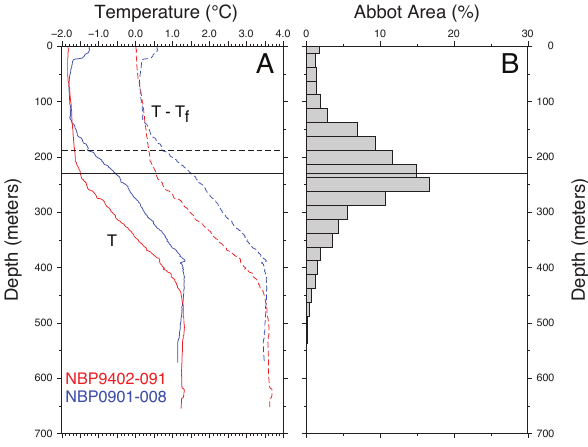
Fig. 6. (a) Measured temperature ( T ) and calculated temperature above the in situ freezing point ( T − T f ) on 13 March 1994 (CTD 091) and 14 January 2009 (CTD 008) (Giulivi and Jacobs, 1997; Ja- cobs et al., 2011) at the locations shown in Fig. 4. (b) Depth distri- bution of Abbot Ice Shelf drafts calculated from the 1km Bedmap2 compilation of surface elevation and ice thickness (Fretwell et al., 2013). Solid horizontal lines show the mean draft determined from the Bedmap2 compilation; dashed line in (a) shows the mean draft determined from OIB surface elevation and ice thickness data (Fig.